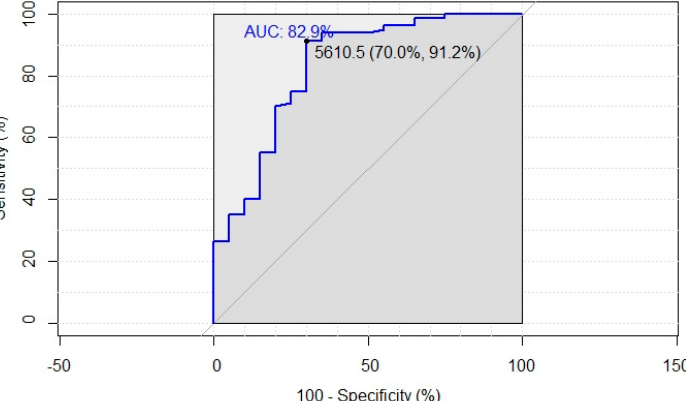
Figure 2. Receiver operating characteristic (ROC) analysis assessing the ability of anti-S IgG at T2 to predict neutralizing antibodies titer against wild type strain. Table 3. Neutralizing antibodies geometric mean titers against the wild-type strain and the Omicron variant, 21 days after the first (T1) and 21 days after the second mRNA vaccine dose (T2), in a sub- group of healthy inmates.